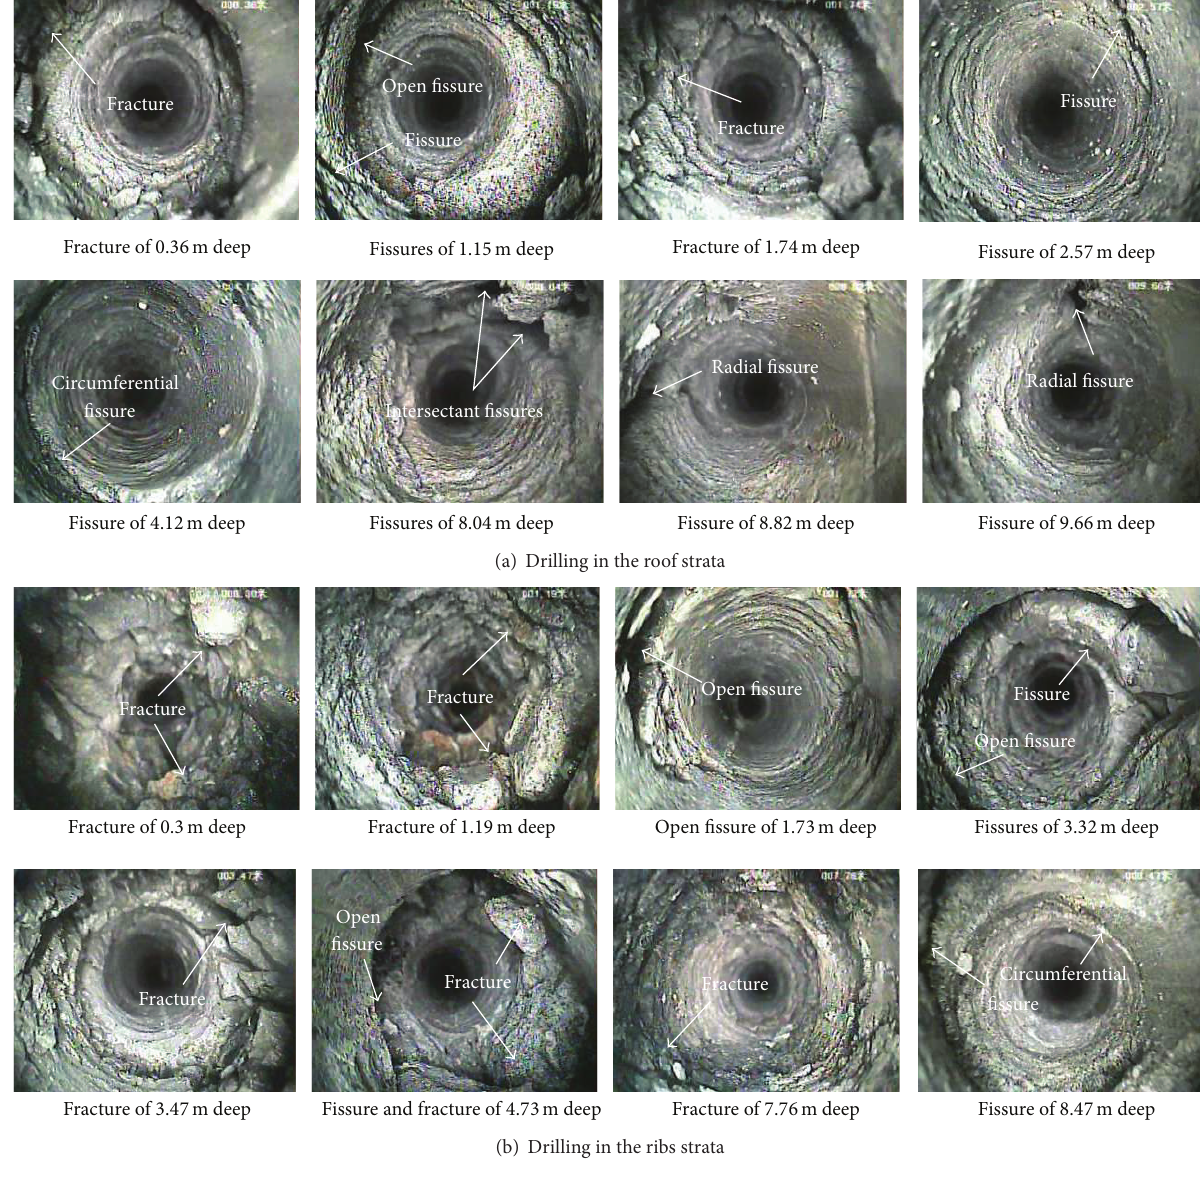
Figure 8: Fracture patterns of surrounding rocks from borehole TV